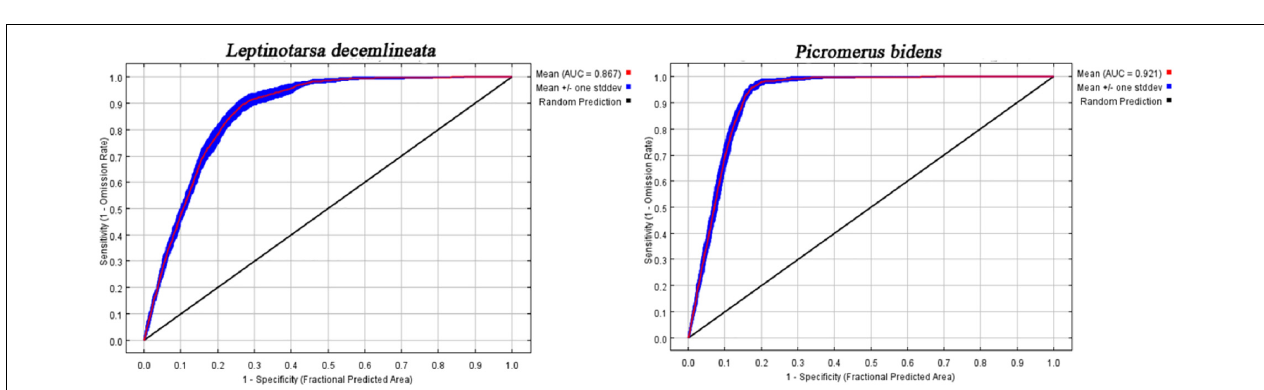
FIGURE 2 | The AIC value of the parameter combination (FC, RM) calculated based on ENMeval.